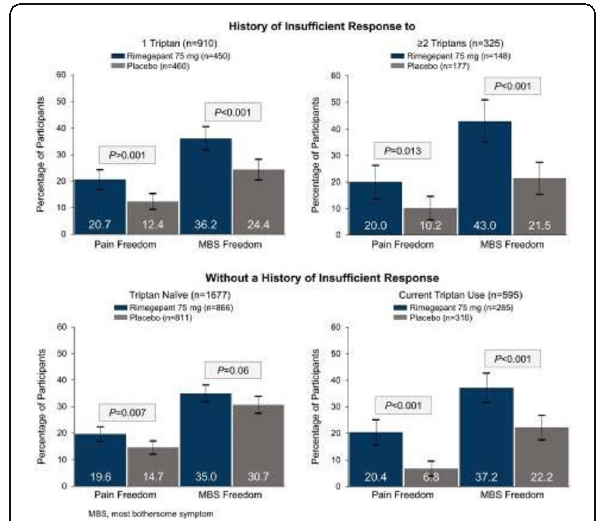
Fig. 1 (abstract P115). Co-primary Efficacy Endpoints at 2 Hours Postdose by Triptan Experience